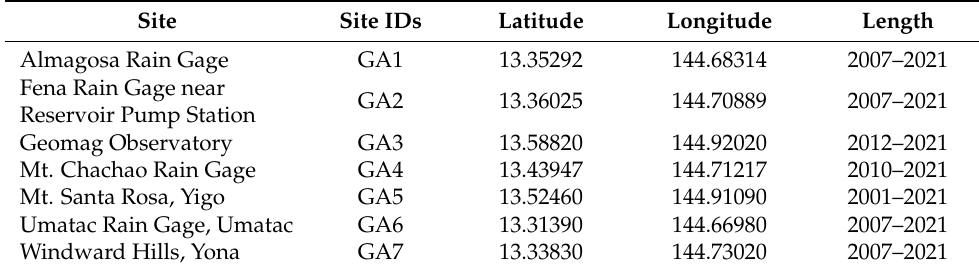
Table 1. Geographical information of the selected 7 rain stations.